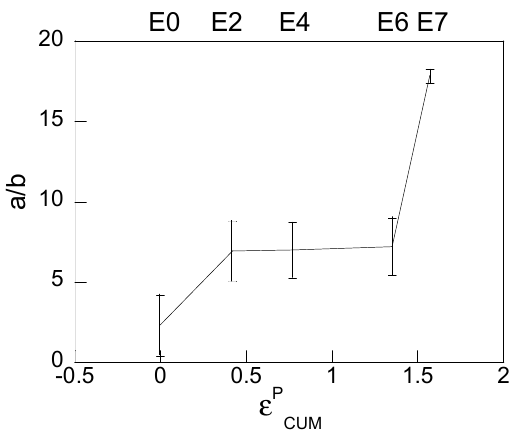
Figure 9. Shape factor evolution for soft -type inclusions.